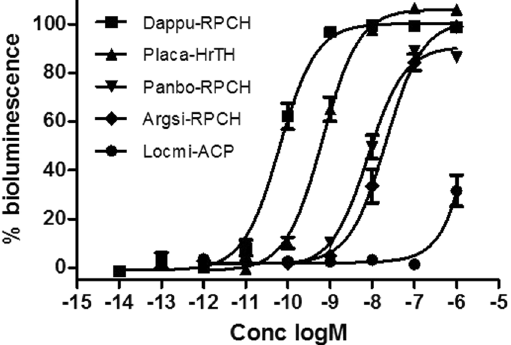
Figure 4. Dose-response curves of Dappu-RPCH and other structurally related peptides tested on Dappu- RPCHR expressing cells in an in vitro bioluminescent assay. Data shown as Mean ± SD, each experiment was performed in triplicate, and % bioluminescence is a proxy for receptor activation. Table 1 shows peptide structure and EC 50 values.